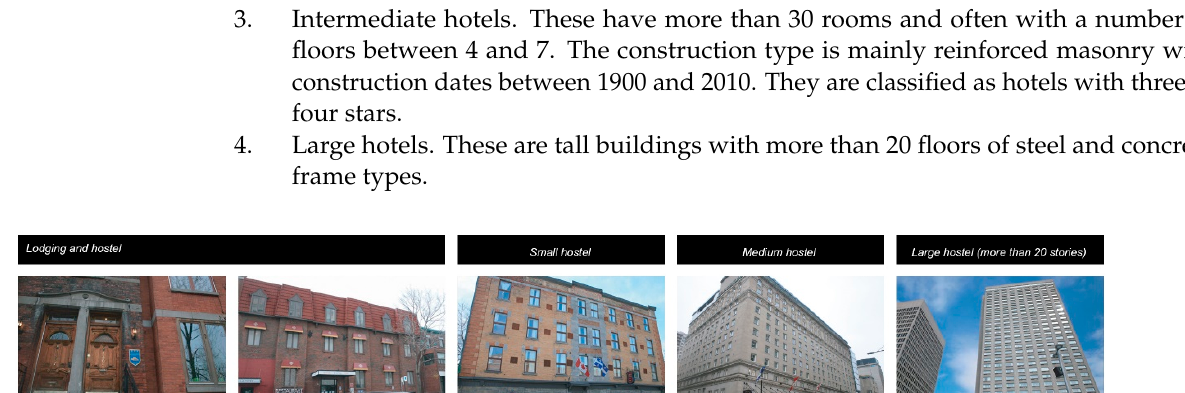
Table 1. Criteria used to determine the building seismic vulnerability (adapted from NRC1992, NBCC2005, and